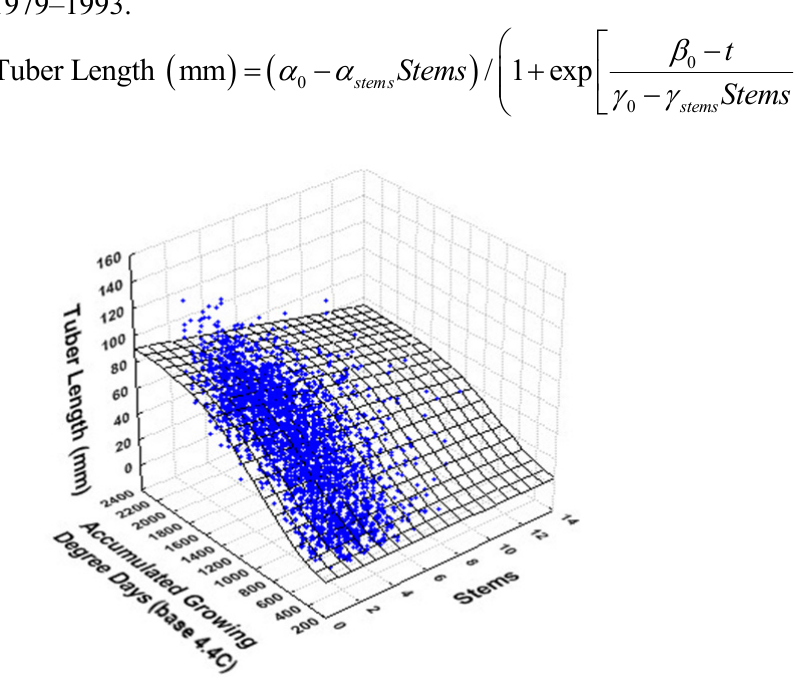
Figure 2. Observed (points) and estimated average potato tuber length (smoothed curve) across accumulated growing degree days and stem number per plant in field trials near Hancock, WI from